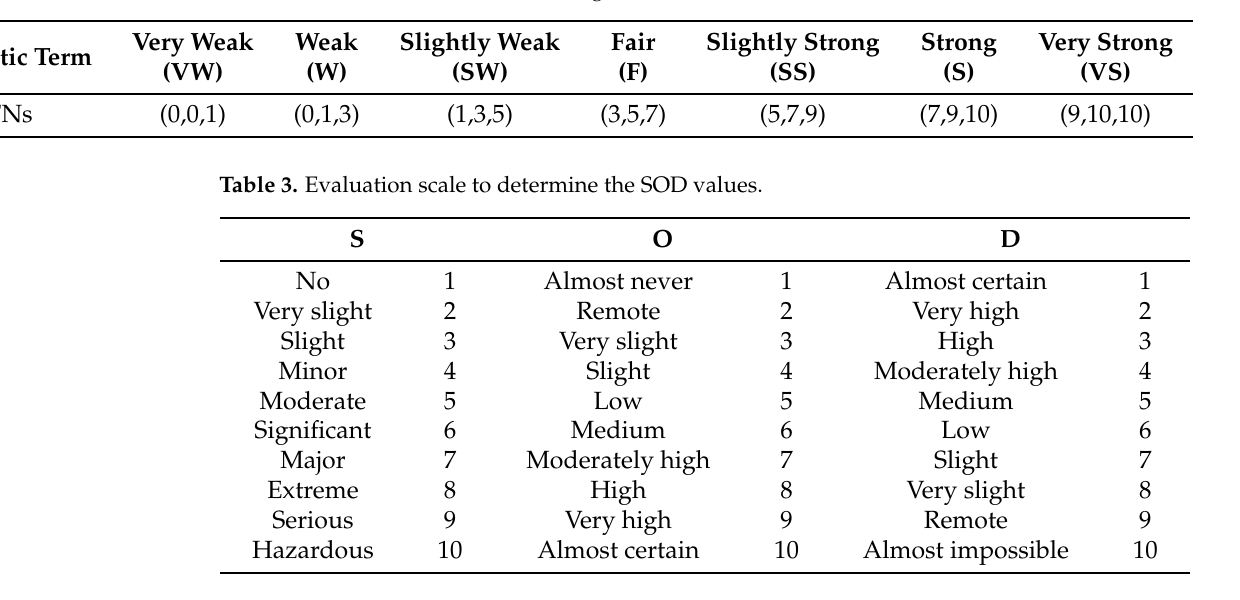
Table 2. Failure modes linguistic variables.